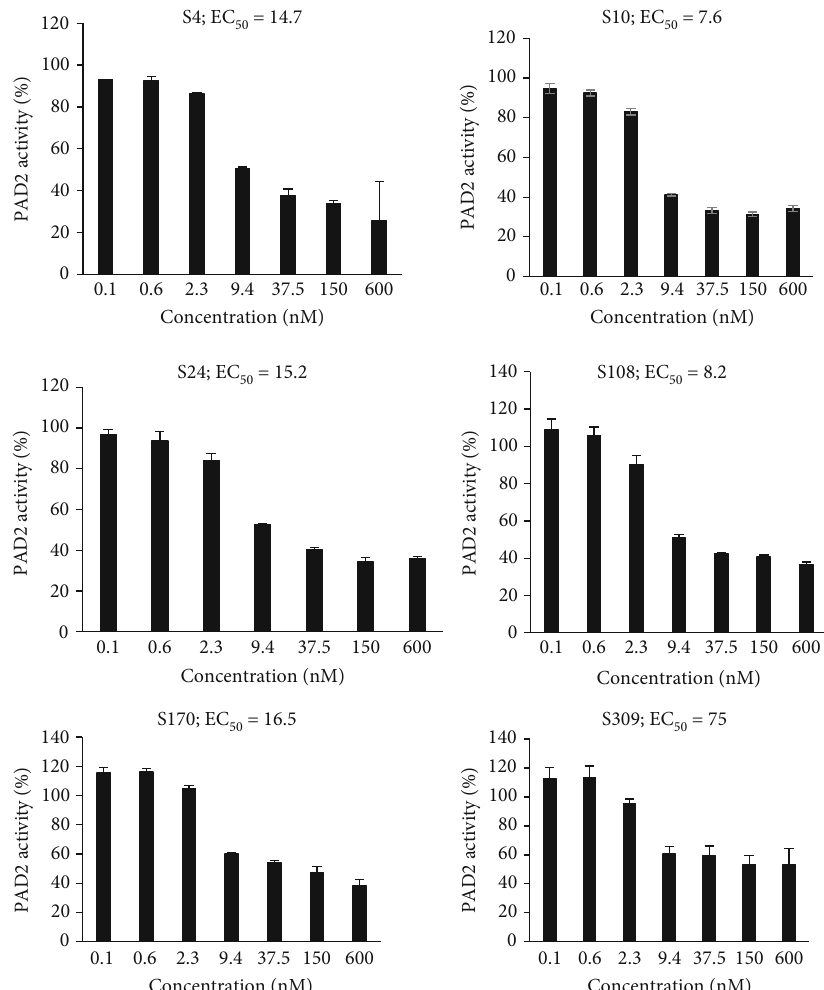
Figure 4: Ability of anti-PAD2 antibodies to inhibit recombinant human PAD2- (rhPAD2-) mediated histone citrullination. The anti-PAD2 antibodies were mixed with rhPAD2 and bu ff er as described in the legend of Figure 3 at 25 ° C for 30 min. Histone (1.8mg/mL) and CaCl (1 mM) were added simultaneously and the mixture was incubated for 4h at 37 ° C. Citrullinated histone was determined using a colorimetric assay. Table 2: Alanine scanning of epitopes along with their half-maximal e ff ective concentration. EC linked immunosorbent assay ∗ . Residue no.